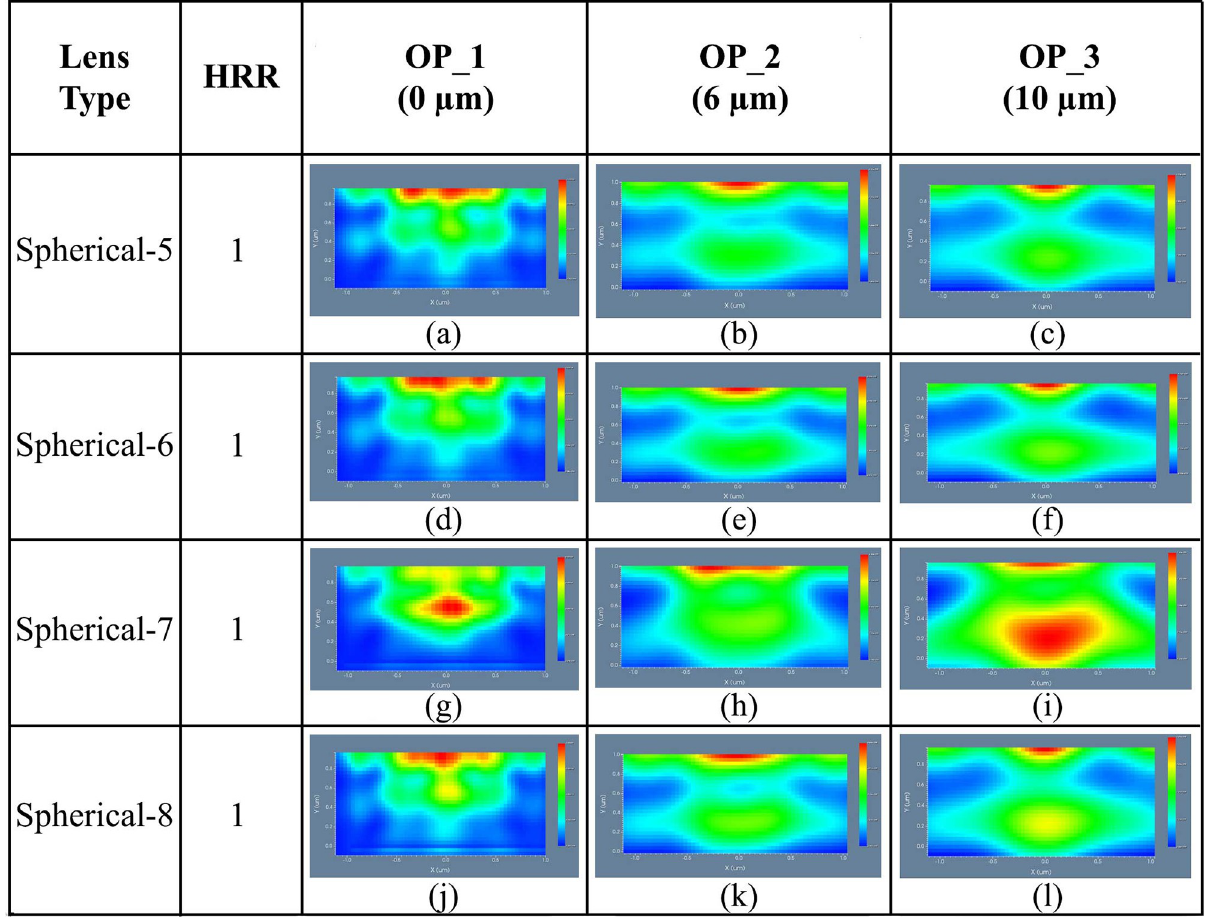
Fig 10. 2D image map of Ey for spherical planoconcave MLA engraved OLEDs: (a)-(c) Spherical-5; (d)-(f) Spherical-6; (g)-(i) Spherical-7; (j)-(l) Spherical 8: (a), (d), (g), (j) OP_1; (b), (e), (h), (k) OP_2; (c), (f), (i), (l) OP_3.